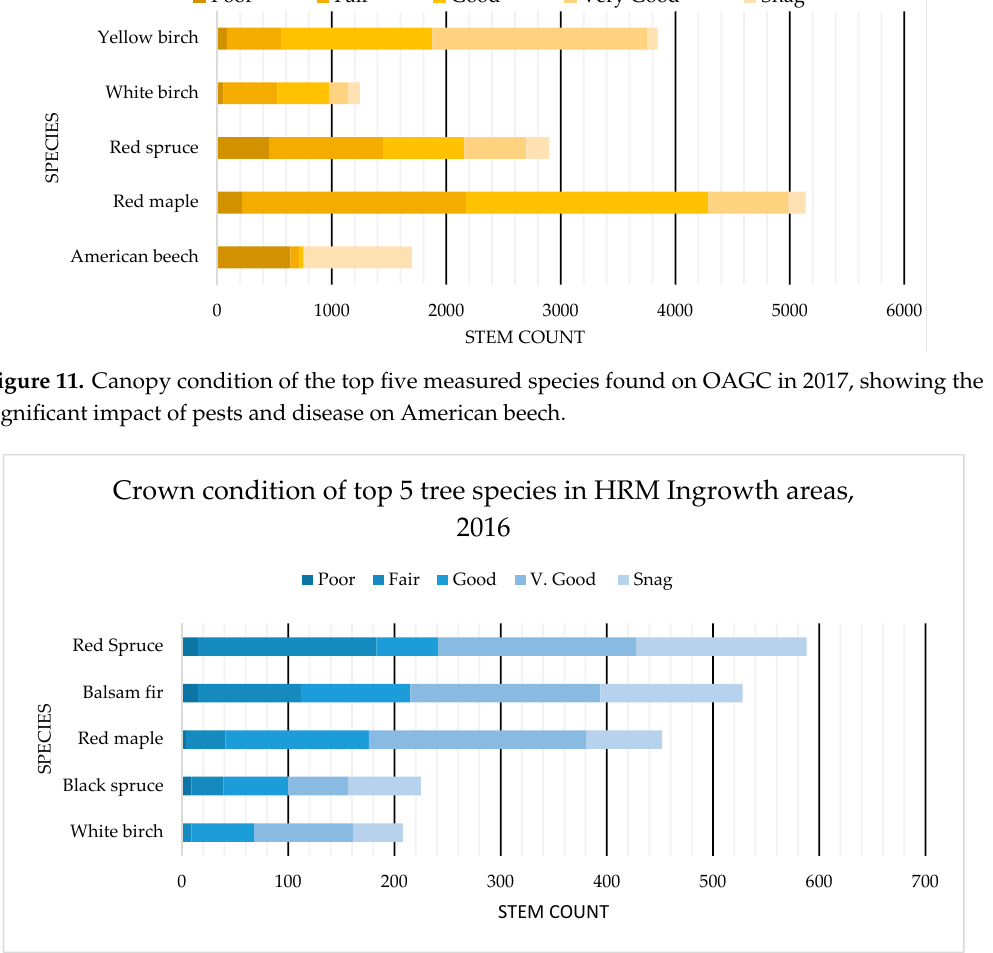
Figure 12. Canopy condition of top five species in HRM ingrowth areas, 2016 [adapted from source data: 11] demonstrating significant dieback across all species.